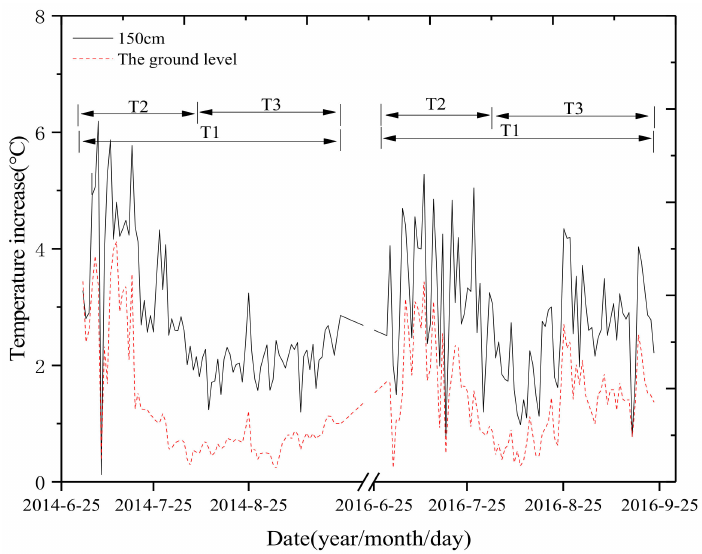
Figure 3. The average night time temperature increase under the nocturnal warming as compared with the control at 150 cm above-ground and at the ground level during the 2014 and 2016 maize growth season. T2 and T3 denote nocturnal warming during vegetative stages (from V4 to a week presilking) and the reproductive stages (from a week presilking to R6), respectively; and T1 denotes nocturnal warming at the whole growth duration between V4 to